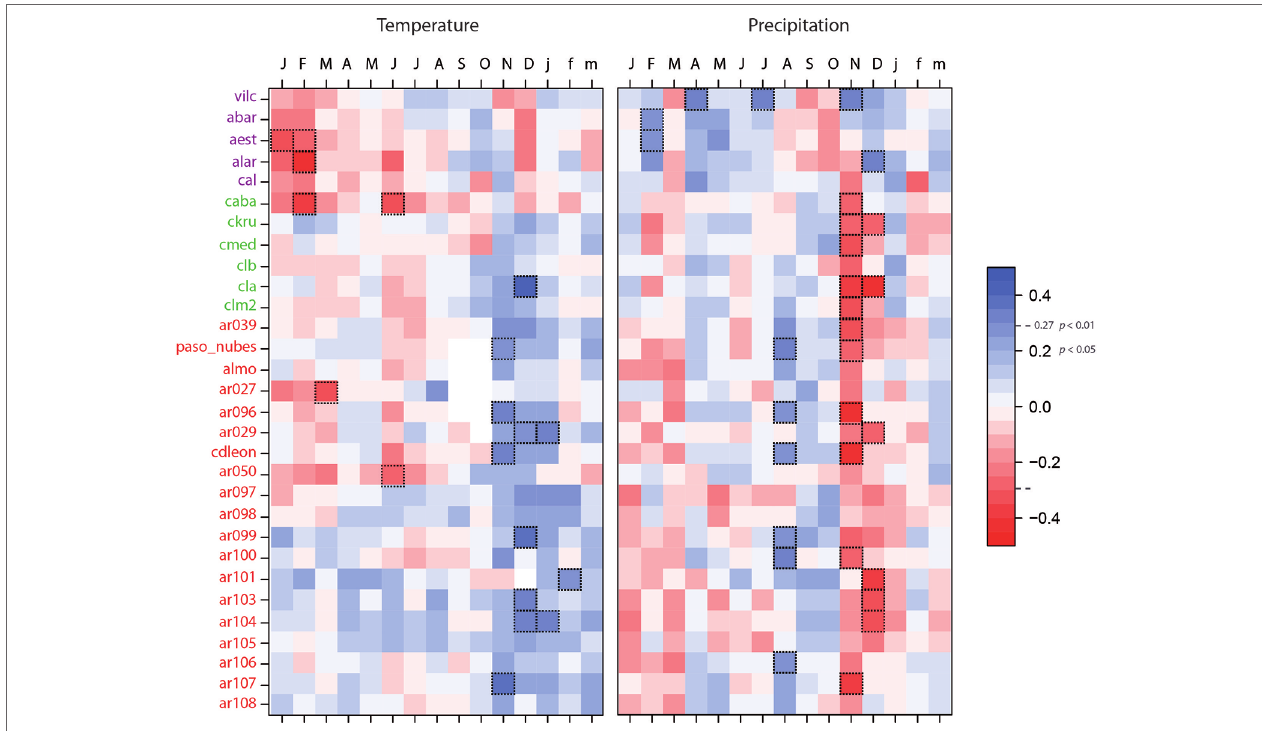
FIGURe 3 | Growth-climate relationships for the studied Nothofagus pumilio populations. Correlations were performed across the common period 1900–1991. Sites are sorted by latitude. Purple sites corresponded to Diguillin region (Chilean north distribution), green sites to Temuco region (Chilean west distribution) and red sites to Bariloche region (Argentinean east distribution). Correlations showing P 0.01 are highlighted with dotted line boxes.